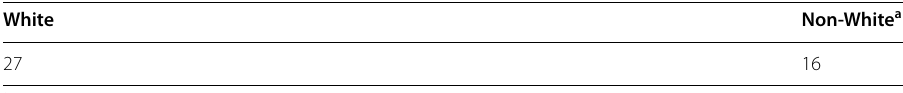
Table 2 Semi-structured interviews: teachers and providers by race